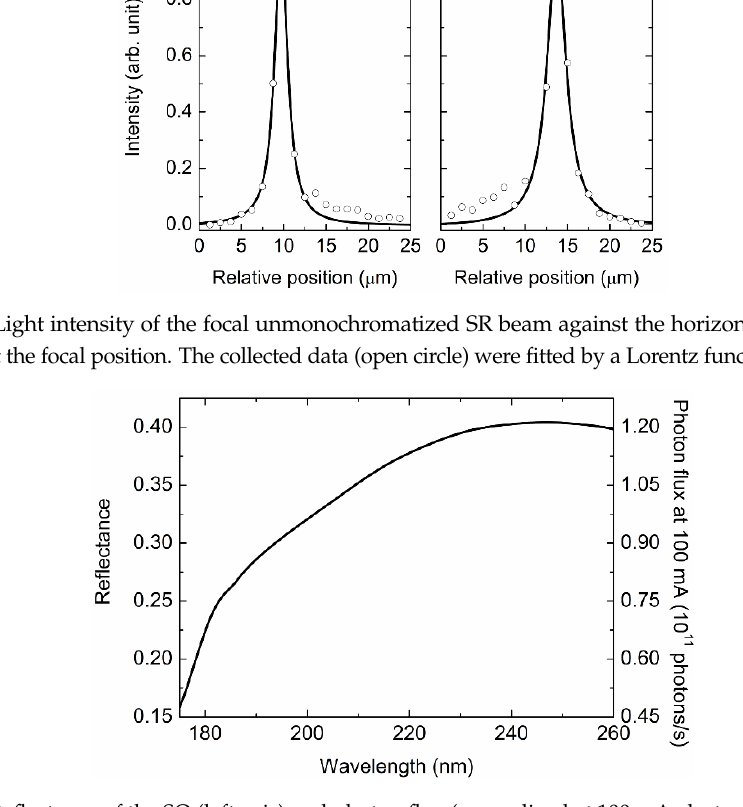
Figure 3. Reflectance of the SO (left axis) and photon flux (normalized at 100 mA electron beam current) after passing through the SO (right axis) in the wavelength region of 175–260 nm.